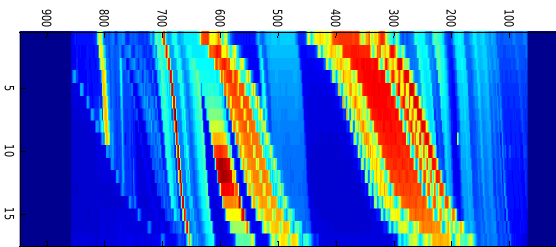
Figure 4. Slice in the Epi-bloc along the (U,Time) direction for a given point along the V